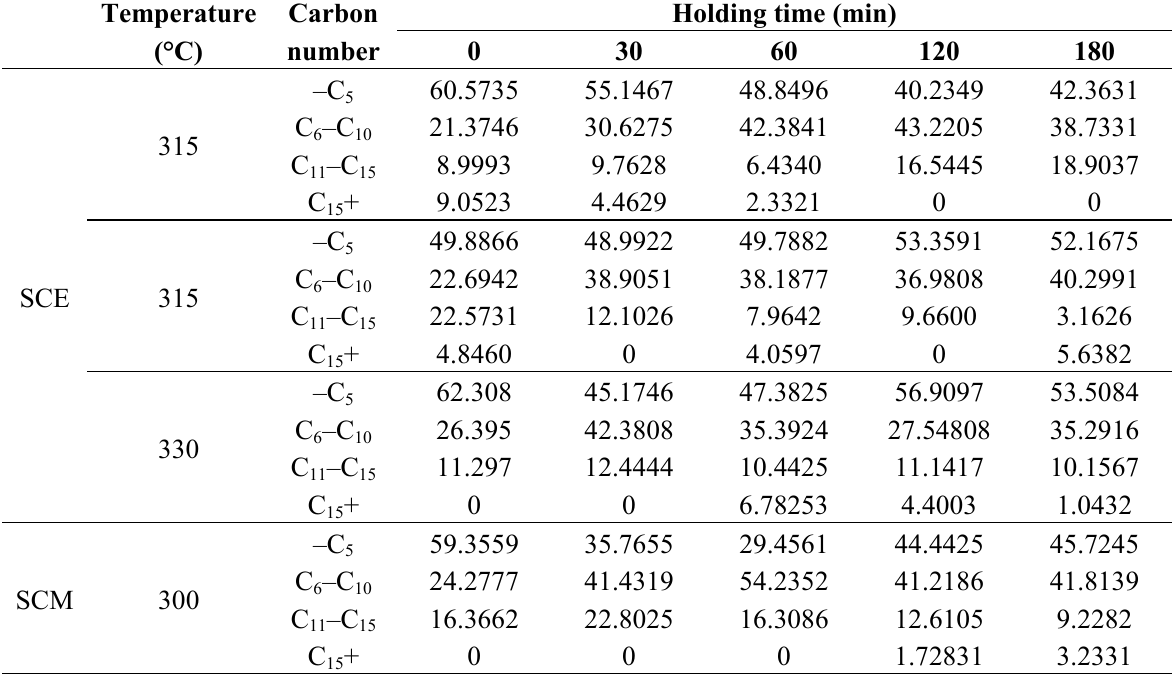
Holding Time (min) Table 5. The weight percentage of compounds according to the carbon number of liquid products obtained at different holding